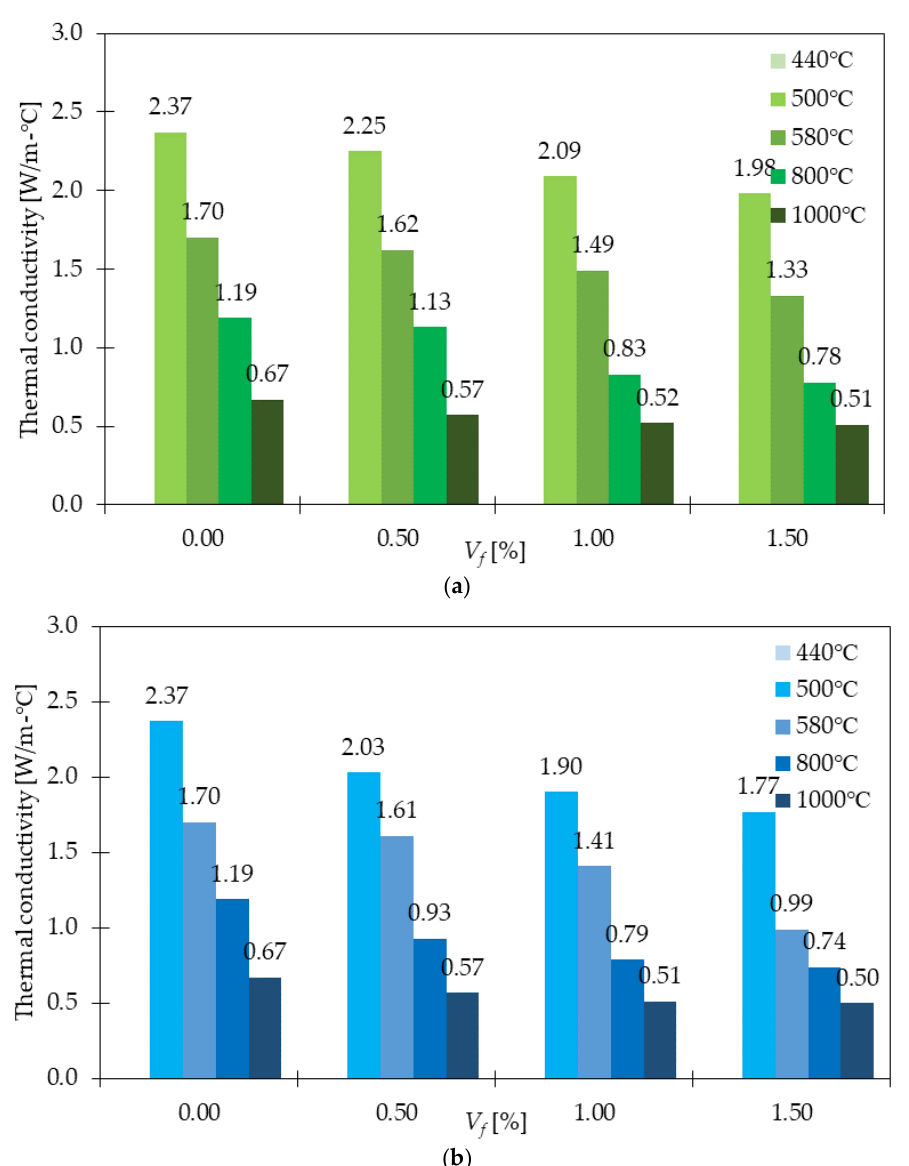
Figure 23. Thermal conductivity in relation to V f for GF with different lengths: ( a ) l f = 6 mm; ( b ) l f = 25.4 mm [29].